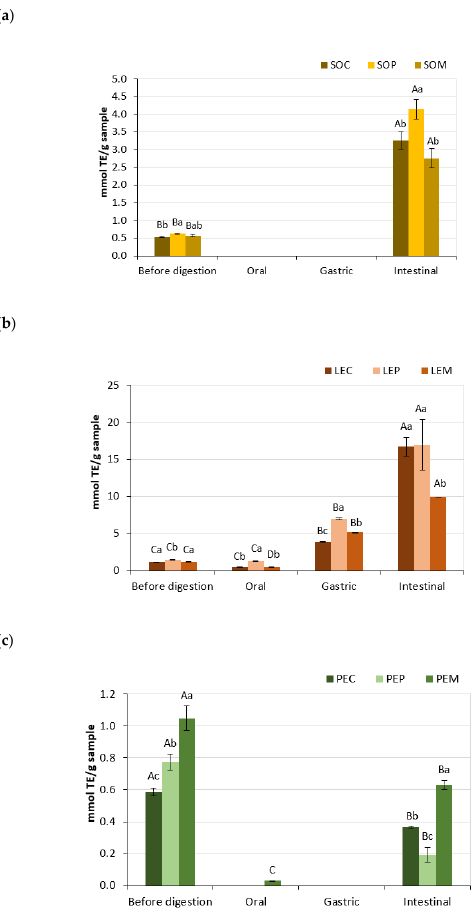
Figure 2. DPPH (2,2-diphenyl-1-picrylhydrazyl) radical scavenging activity of legume pastes from ( a ) soybean, ( b ) lentil, and ( c ) pea subjected to different cooking methods (SOC, ordinary cooked soybean; SOP, pressure-cooked soybean; SOM, microwave-cooked soybean; LEC, ordinary cooked lentil; LEP, pressure-cooked lentil; LEM, microwave-cooked lentil; PEC, ordinary cooked pea; PEP, pressure-cooked pea; PEM, microwave-cooked pea). Capital letter indicates significant differences between phases (before digestion, oral, gastric, and intestinal digestion) within the same legume sample and treatment ( p < 0.05), whereas lowercase letter indicates significant differences between treated samples (cooking, pressure cooking, and microwave) within the same legume and phase ( p < 0.05).